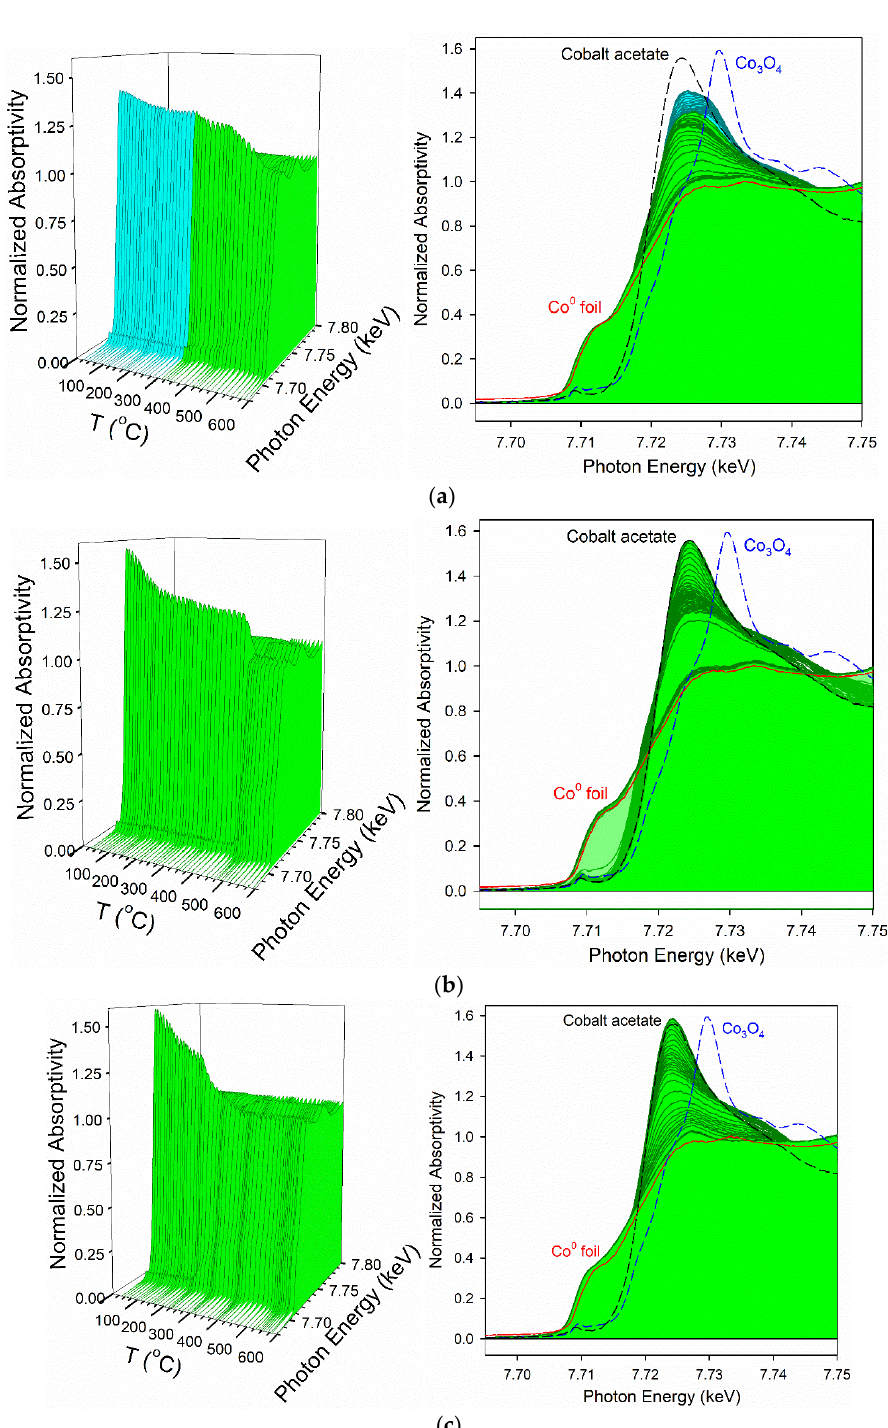
Figure 5. TPR-XANES profiles of ( a ) calcined 12% Co/SiO 2 from cobalt acetate, ( b ) uncalcined 12% Co/SiO 2 from cobalt acetate, and ( c ) uncalcined 0.5% Pt-12% Co/SiO 2 from cobalt acetate.